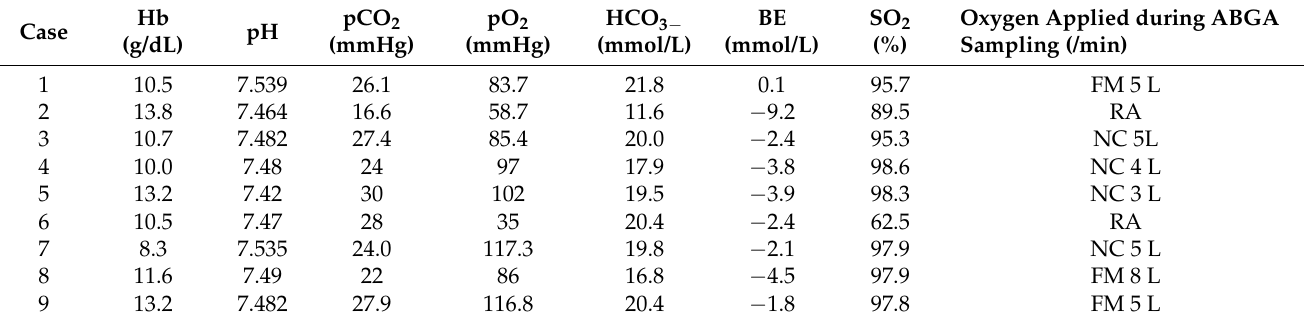
Table A1. The results of arterial blood gas analyses concerning patients with